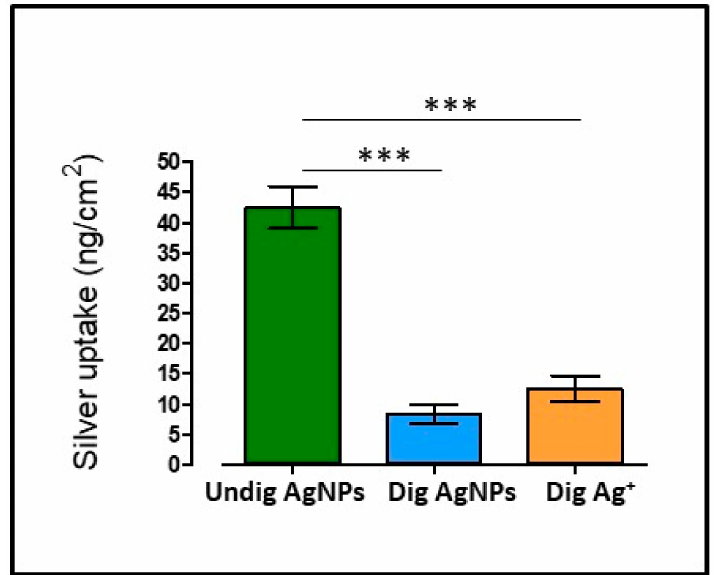
Figure 4. Uptake of undig AgNPs (green), dig AgNPs (light blue) and dig Ag + (orange) by Caco- 2 monolayer after a single exposure. Statistical significance is represented with respect to Undig AgNPs (*** p <